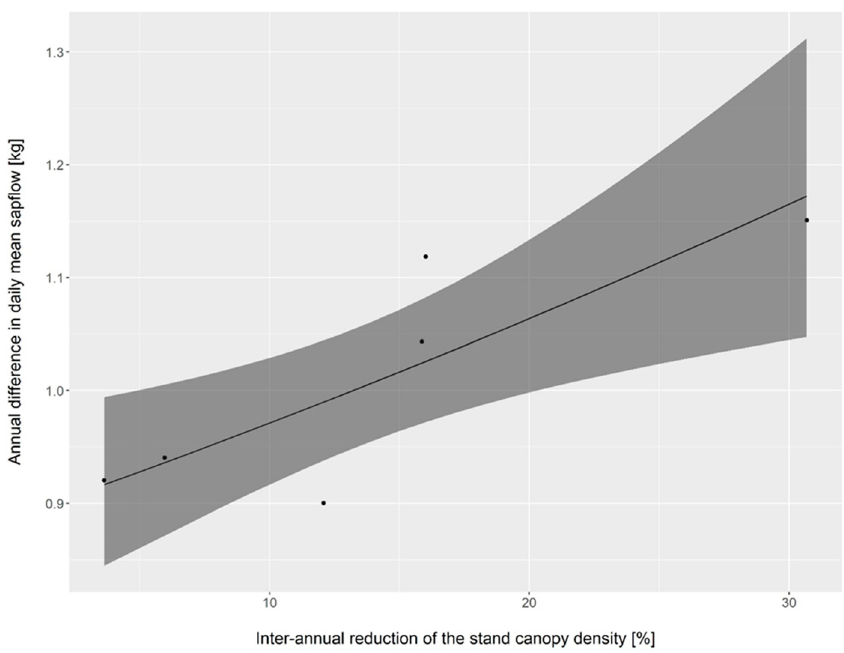
Figure 4. Relationship between stand-canopy density and sap-flow difference on the forest edge with the 95% confidence interval. X-axis reduction in canopy density between 2019 and 2020 on 10-meter buffer around the tree, Y-axis change in sap flow measured df = 4; R 2 = 0.69; p < 0.05).